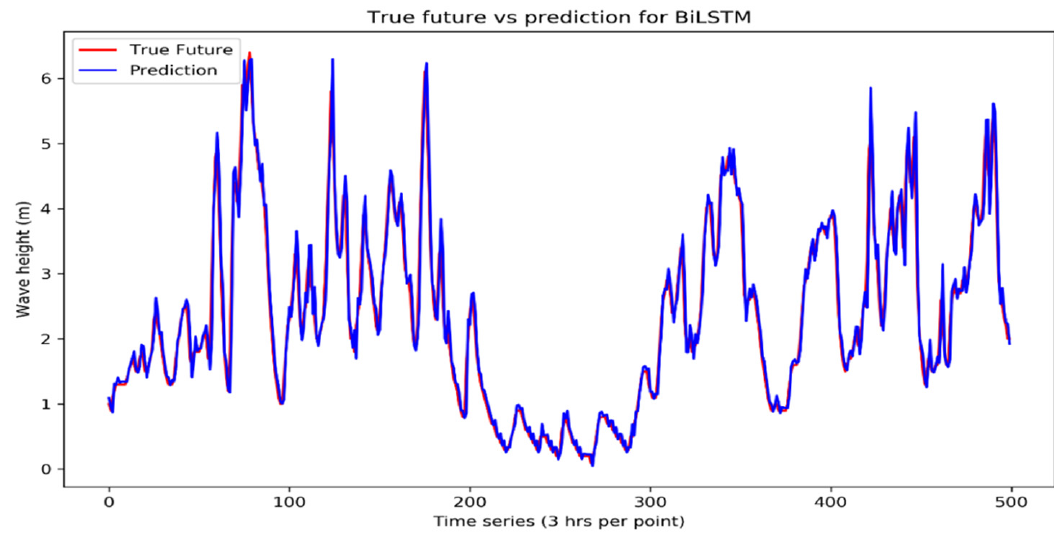
Figure 15. BiLSTM wave height prediction.